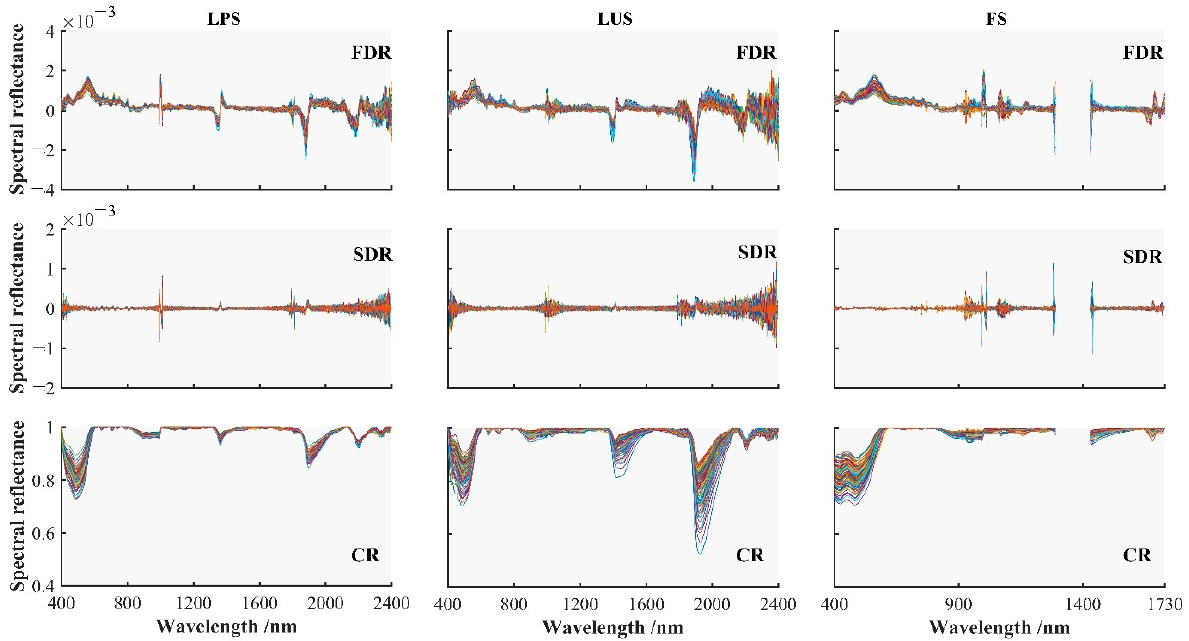
Figure 5. Spectral reflectance curves of soil samples using different spectral transformation methods under three kinds of experimental conditions. Note: Different color lines represent spectra after spectral transformation for each soil sample.